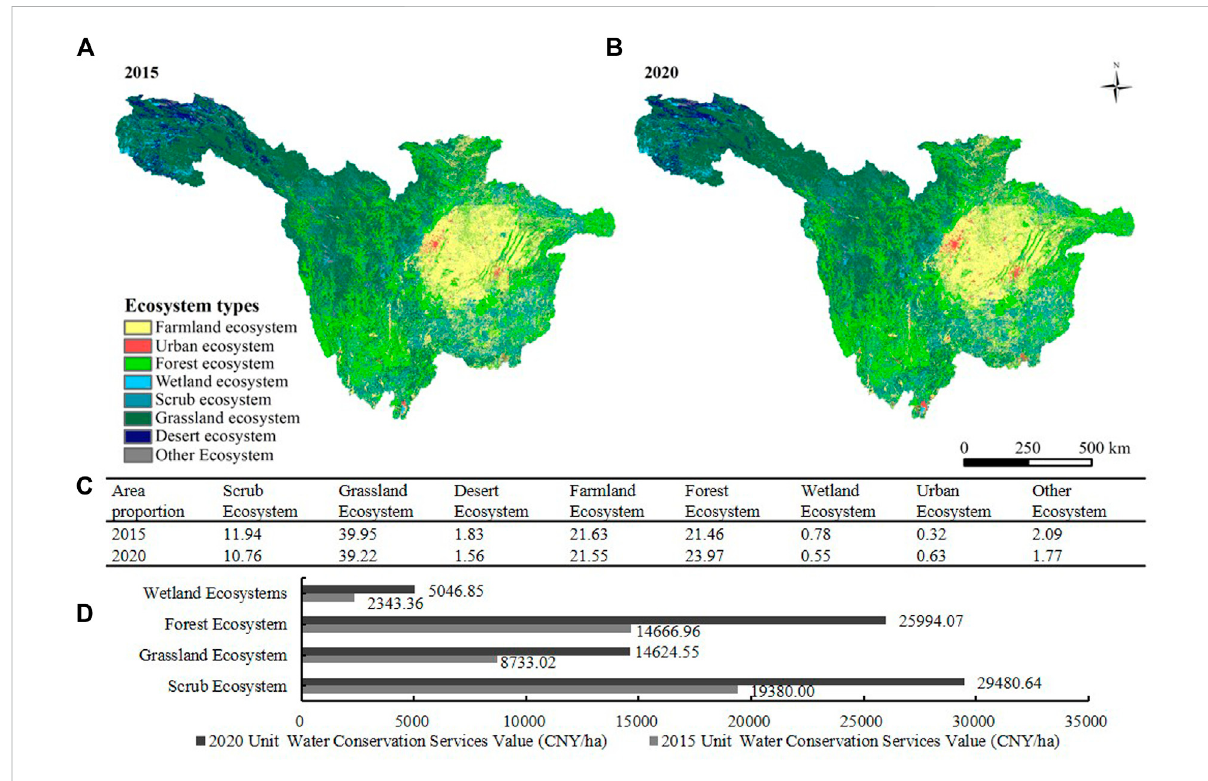
FIGURE 9 Distribution of different ecosystems in the upper Yangtze River and water conservation service value. (A) different ecosystems in 2015; (B) different ecosystems in 2020; (C) Area proportion of different ecosystems; (D) water conservation service value of different ecosystems.